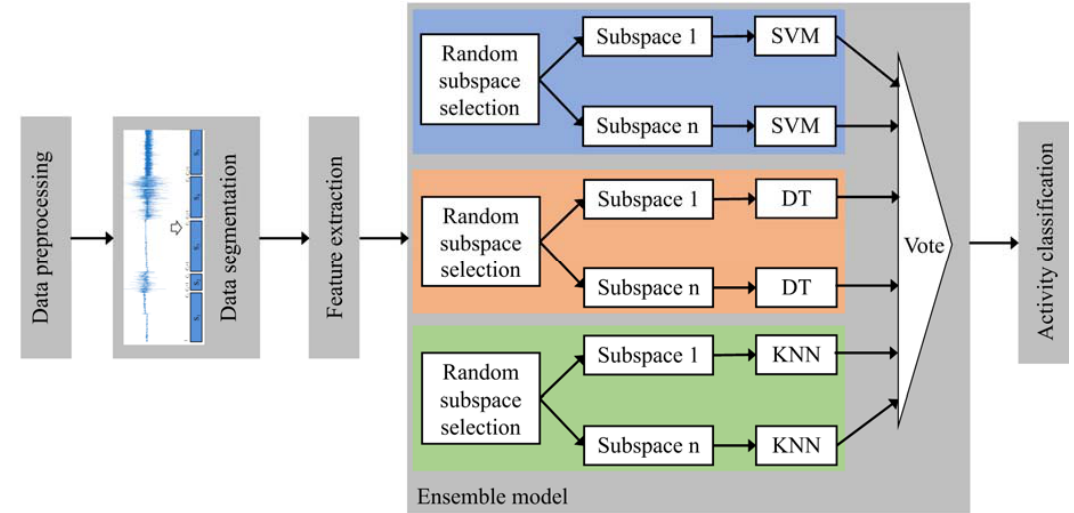
Figure 1. The conceptual procedure of the ensemble classification approach for activity recognition.